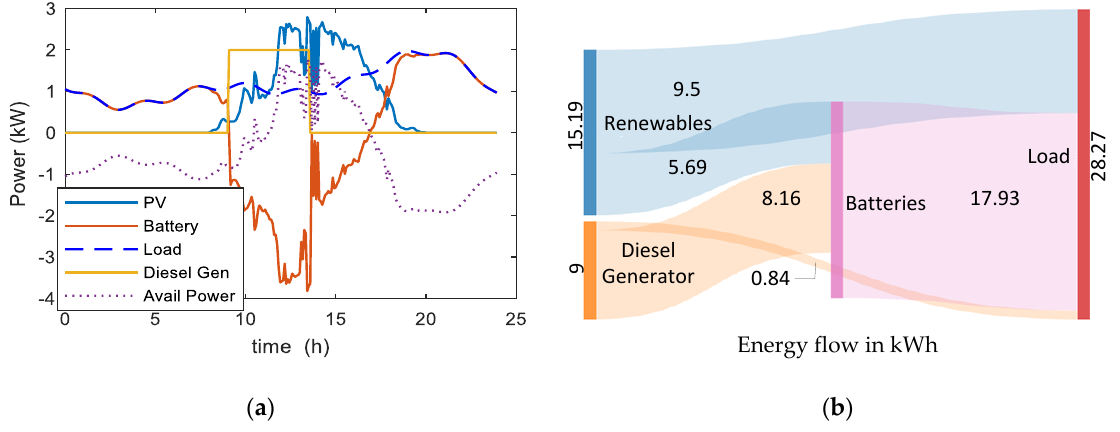
Figure 5. Node 1 at isolated daily operation (NMPC off): ( a ) Systems operation; ( b ) Energy flow (kWh).